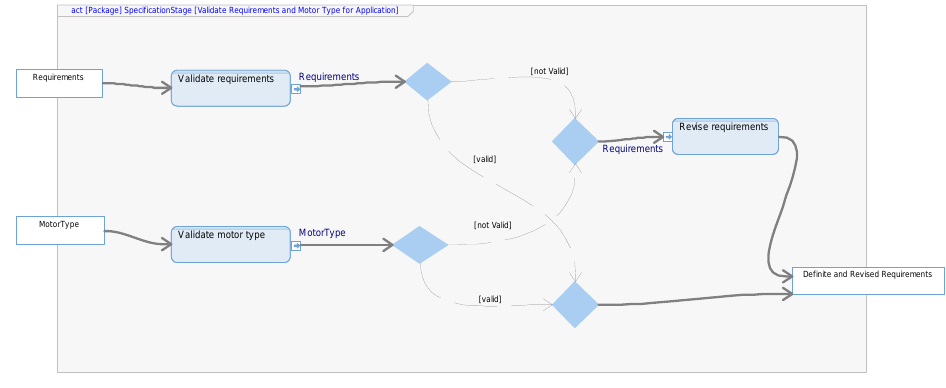
Figure 7. Validate requirements and motor type activity.